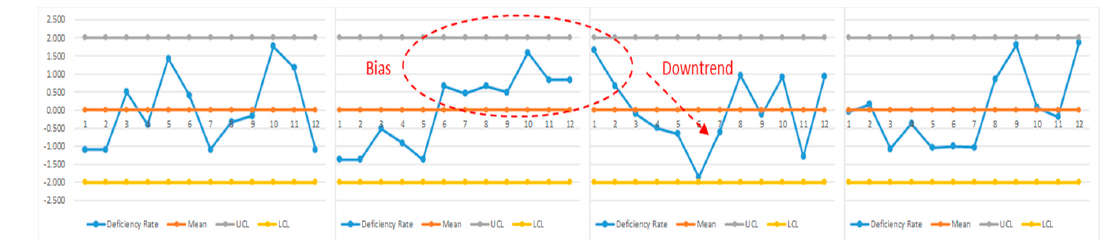
Figure 11. The control chart for deficiency 06 (2015–2018).